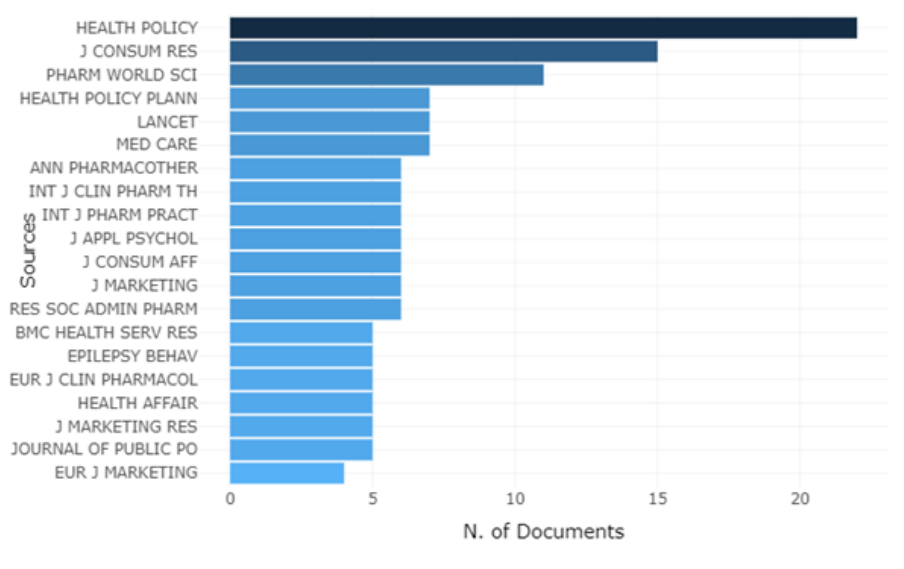
Figure 2. Ranking of the most cited journals.